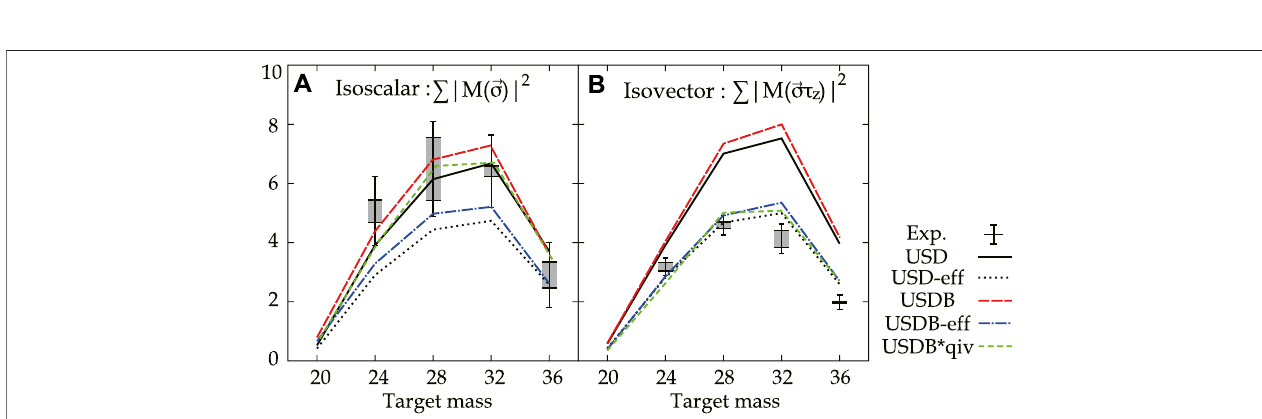
FIGURE 8 | Integrated values of spin- M 1 SNMEs for IS (A) and IV (B) transitions up to E x (cid:1) 16 MeV as a function of the target mass. Error bars indicate the total experimental uncertainties, and gray bands show partial uncertainties from inde fi nite spin assignments. Solid and long-dashed lines indicate the prediction of a shell- model calculation using bare USD and bare USDB interactions, respectively. Dotted and dashed-dotted lines applied empirical quenching factors (see text for more details) to USD and USDB interactions, respectively. The short-dashed lines (green) are calculated using the USDB interaction modi fi cation in the IS spin-triplet interaction and in the IV quenching factor from Sagawa and Suzuki (2018). The fi gures were taken from Matsubara et al. (2015) with some updates using the modi fi ed interactions (Sagawa and Suzuki, 2018).